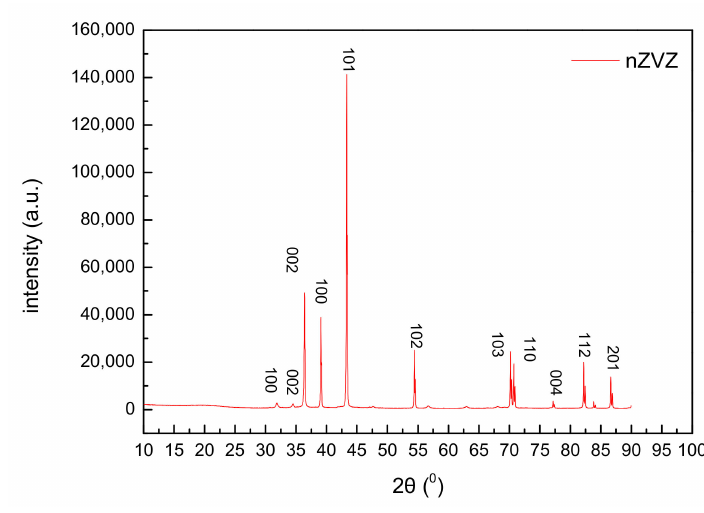
Figure 6. The XRD pattern of the commercially available nanoscale zerovalent zinc (nZVZ).